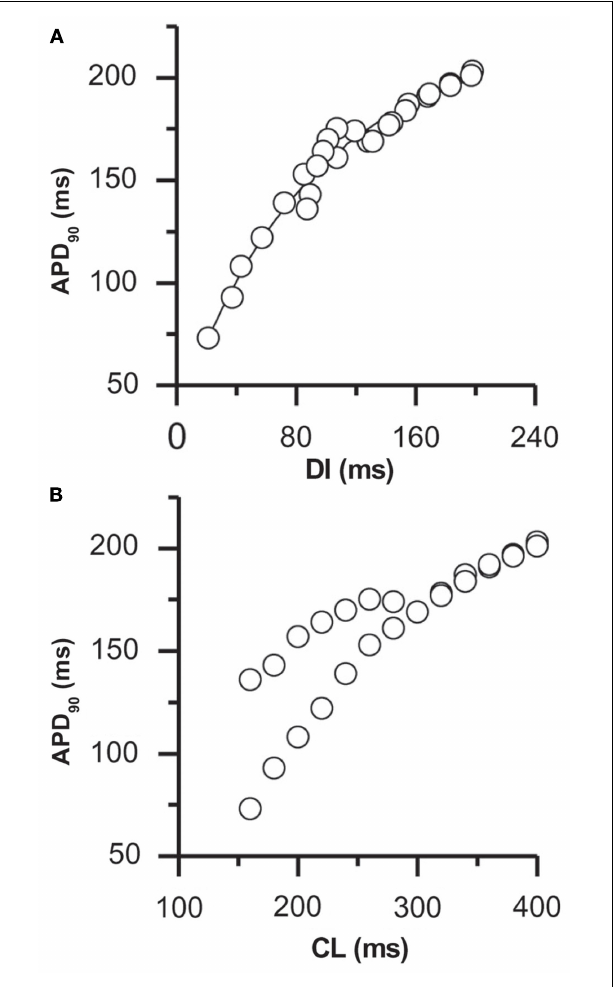
FIGURE 2 |APD restitution in rabbit ventricular myocytes. The rate-dependence of APD is shown by plotting the APD against (A) the duration of the preceding DI and (B) the cycle length (CL; from the same data set). In this myocyte, alternans occurred at a pacing cycle length of 280ms, corresponding to a DI of 120ms.The slope of the restitution curve at this DI was 0.56 (from (A) ), significantly less than the slope predicted to be necessary if alternans results from APD restitution alone. Adapted from Goldhaber et al. (2005). Note that similar data has been reported in human myocardium (see, for example, Koller et al.,